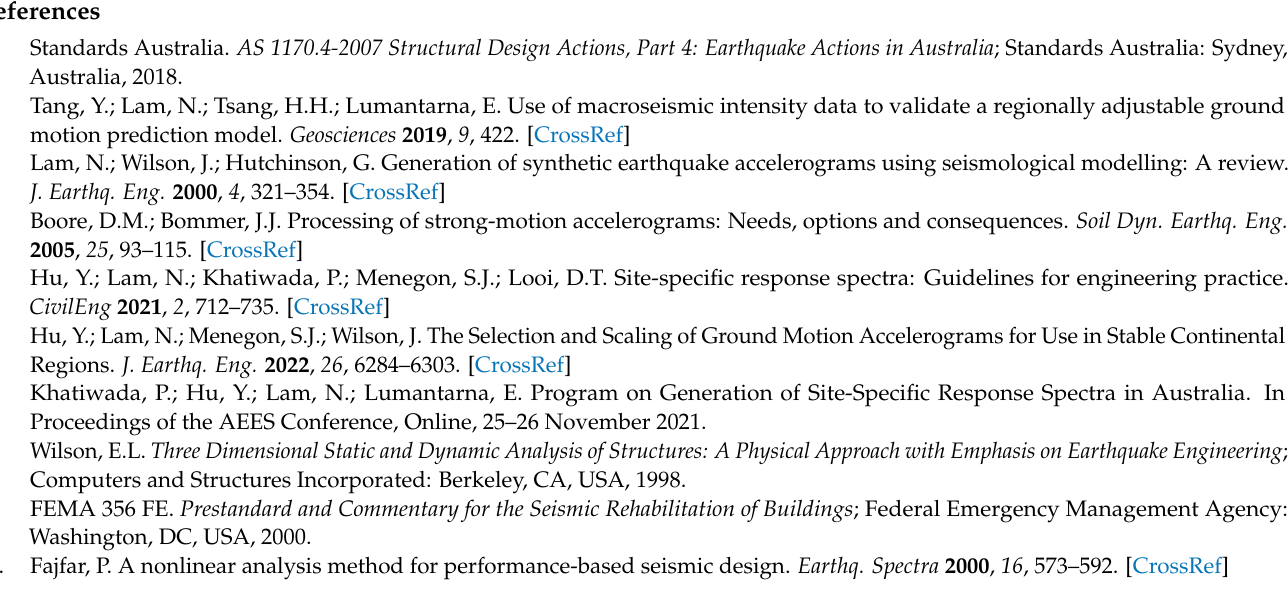
Figure A1. Screenshot of the input parameters defined in the “quakeadvice.org” online program [17].